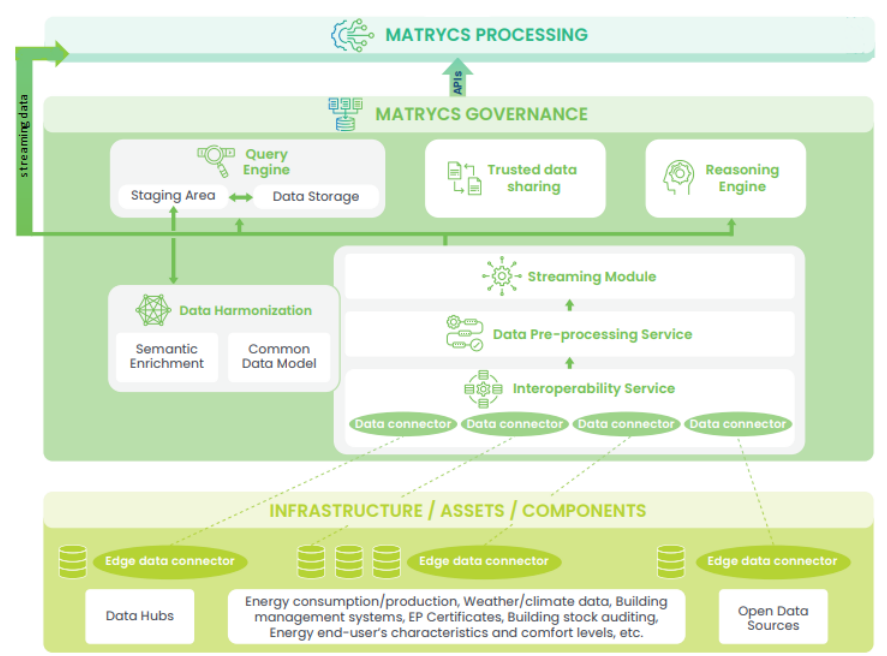
Figure 4. MATRYCS governance layer architecture.